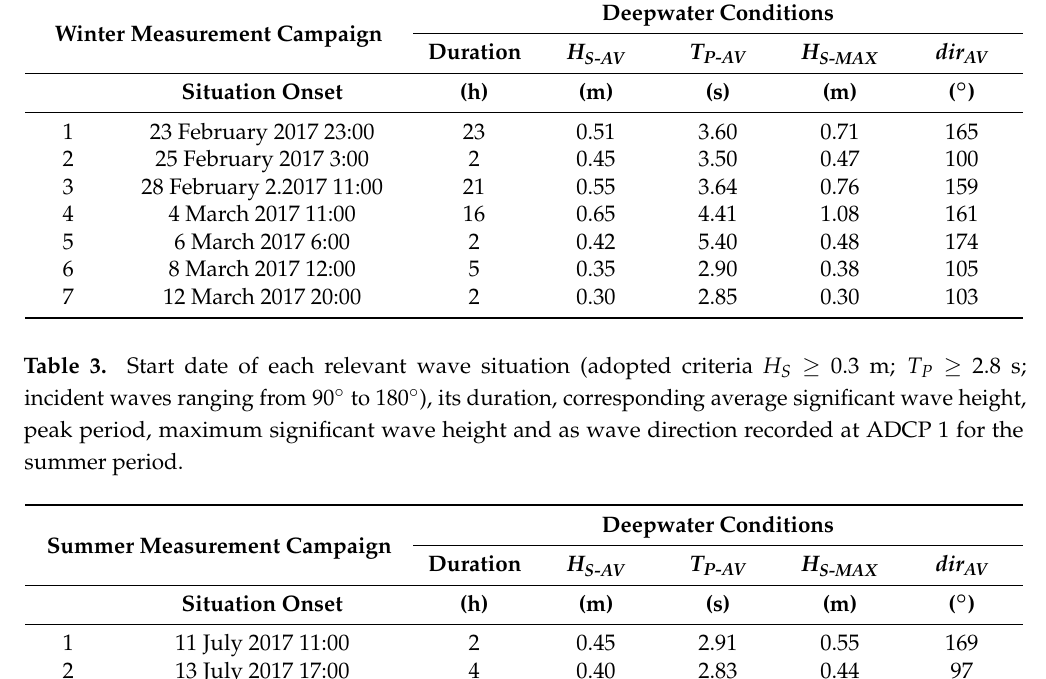
Figure 6. Time series of measured and integrated culvert discharges for the one culvert pipe measured by the PCM device; wave situations characterized by the significant wave height H S ≥ 0.3 m, peak periods T P ≥ 2.8 s in the range from 90° to 180° (marked by red line), days with precipitation intensity >10 mm/day (marked by green arrows), specific situations explained in text marked by magenta line and yellow circle for the ( a ) winter and ( b ) summer measurement periods. Table 2. Start date of each relevant wave situation (adopted criteria H S ≥ 0.3 m; T P ≥ 2.8 s; incident waves ranging from 90° to 180°), its duration, corresponding average significant wave height, peak period, maximum significant wave height and as wave direction recorded at ADCP 1 for the winter period.